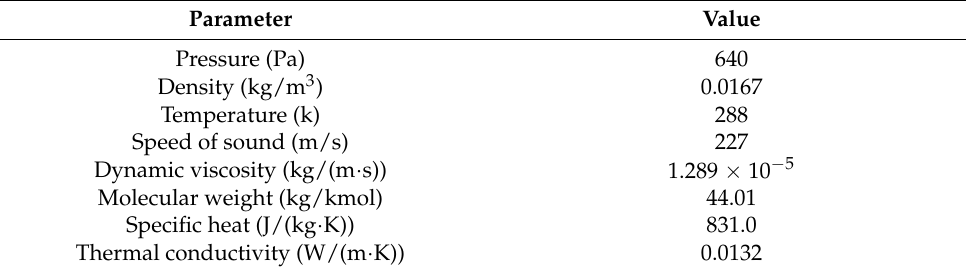
Table 1. Properties of Martian air used for calculation in present study.